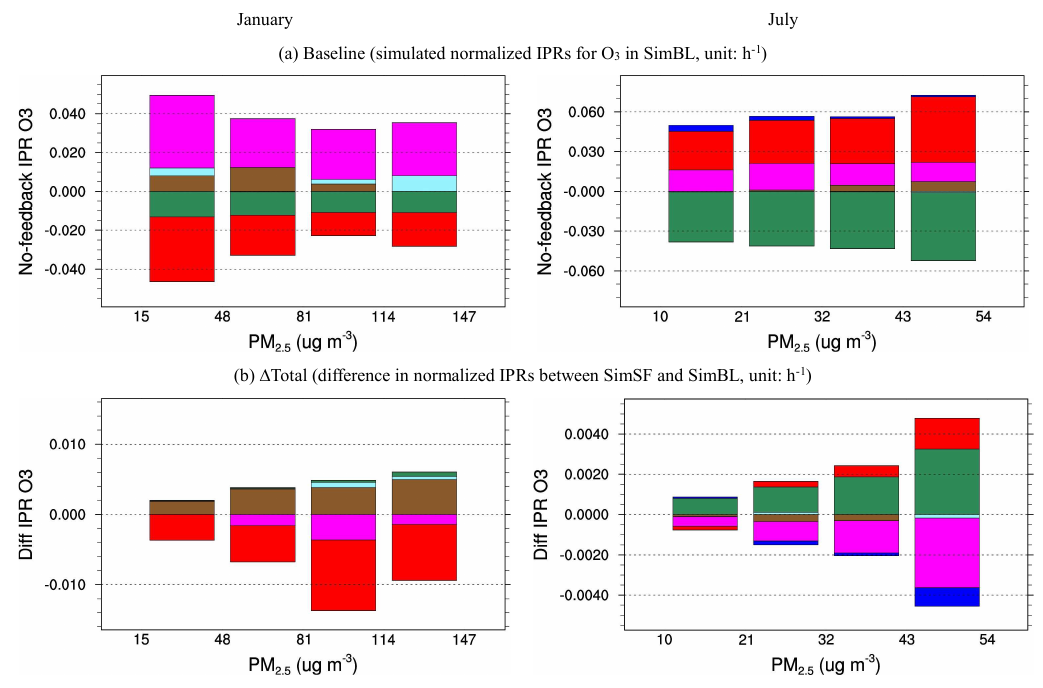
Figure 6. Integrated process contributions to daytime near-ground-level O 3 under different PM 2 . 5 levels in JJJ (between the ground and 350ma.g.l.; model layers